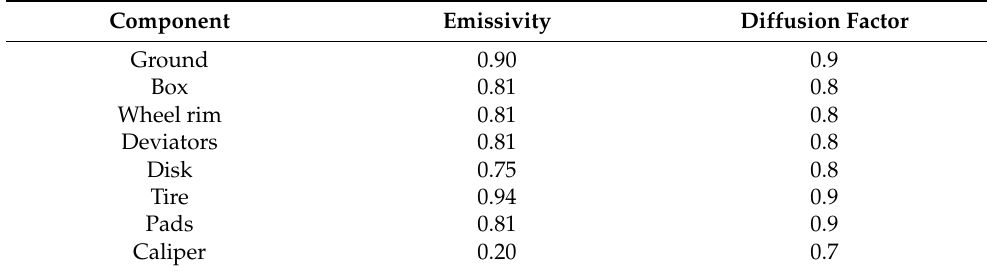
Table 1. Emissivity and diffusion factor values of the brake system components.